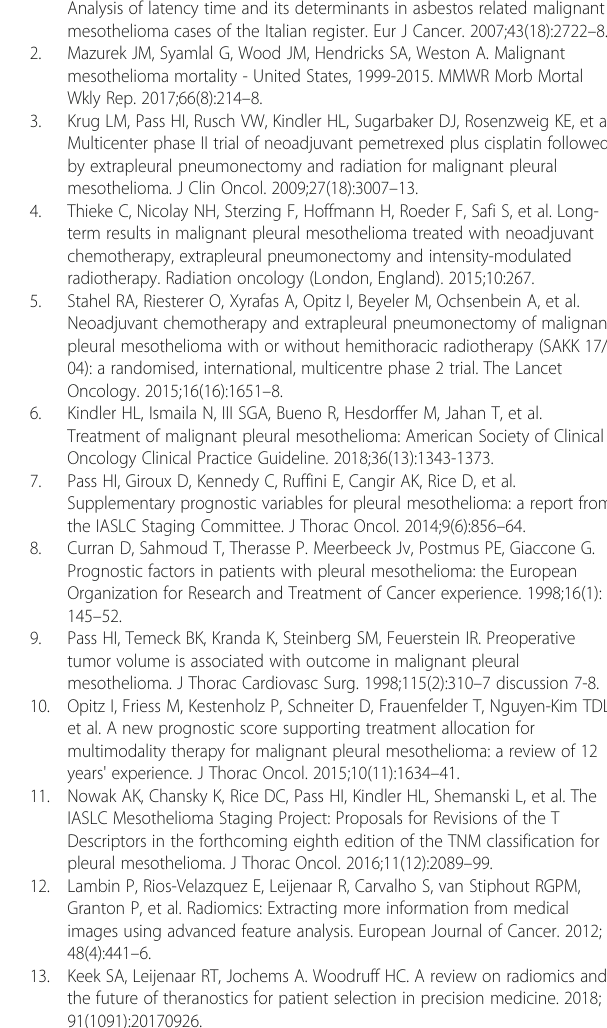
Additional file 2: Figure 1. Cox regression model for volume for OS. Additional file 3. Details on the multivariate Cox regression model for FDG PET radiomics. Abbreviations MPM: Malignant pleural mesothelioma; PFS: Progression-free